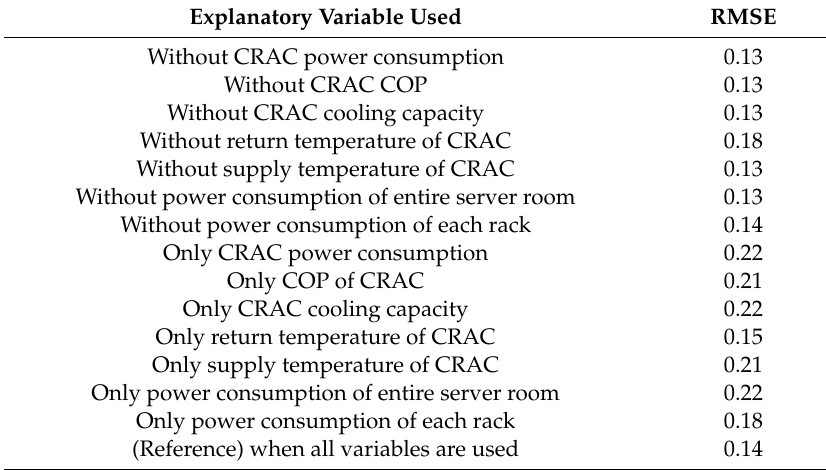
Table 10. RMSE when explanatory variable is